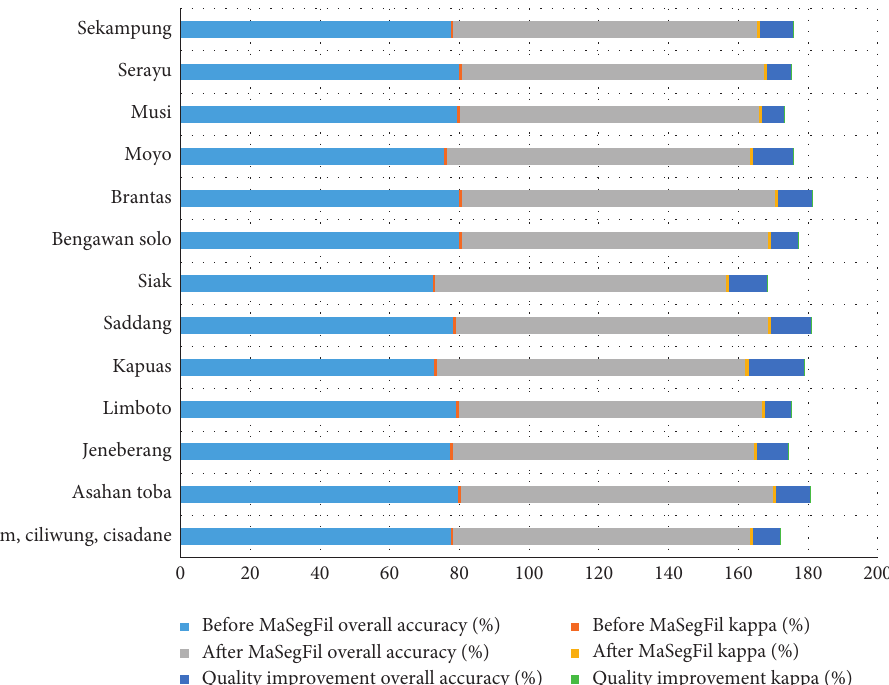
Figure 12: Comparison of the LULC classification accuracy assessment based on the RF classifier before and after using the MaSegFil